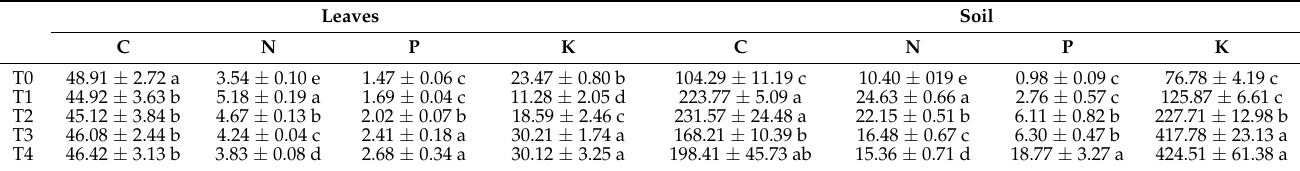
Table 2. Concentrations of total C, N, P, and K in soil and plant leaves under different fertilization treatments. Leaves Soil